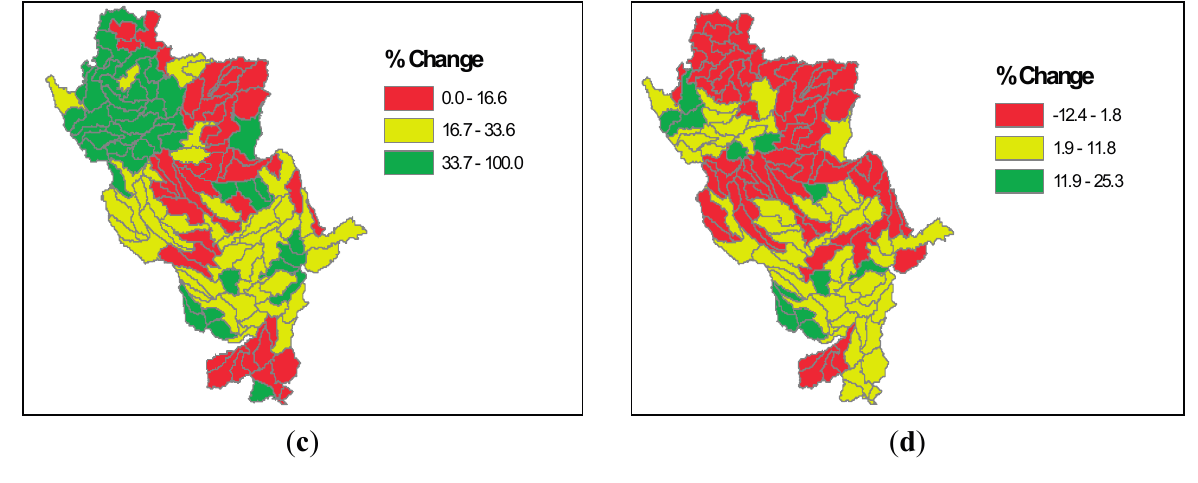
Figure 10. Spatial variation in the % change over baseline of: ( a ) Water Yield; ( b ) ET; ( c ) Sediment load; and ( d ) Total Nitrogen load from a 50% Switchgrass Adaptation (Scenario